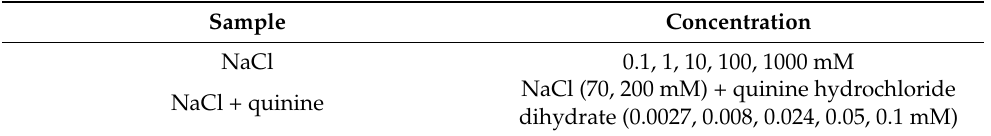
Table 2. Components and concentrations of